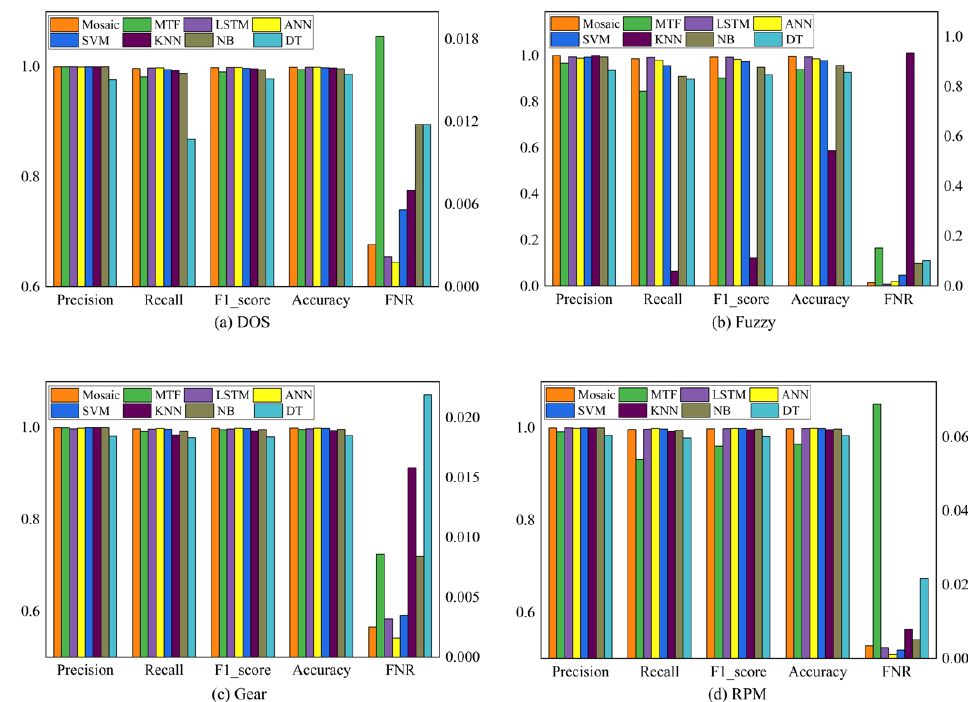
Figure 11. Comparison of the experimental results of our method, with some other classical machine-learning algorithms.